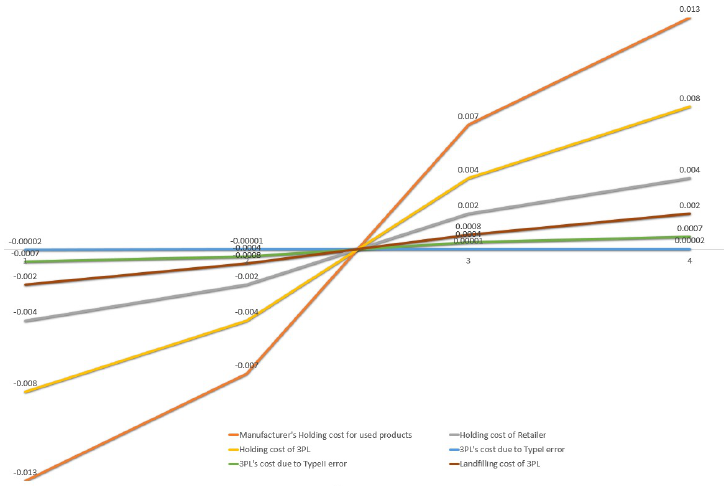
Figure 6. Effect of changes of total cost for changes of various parameters.